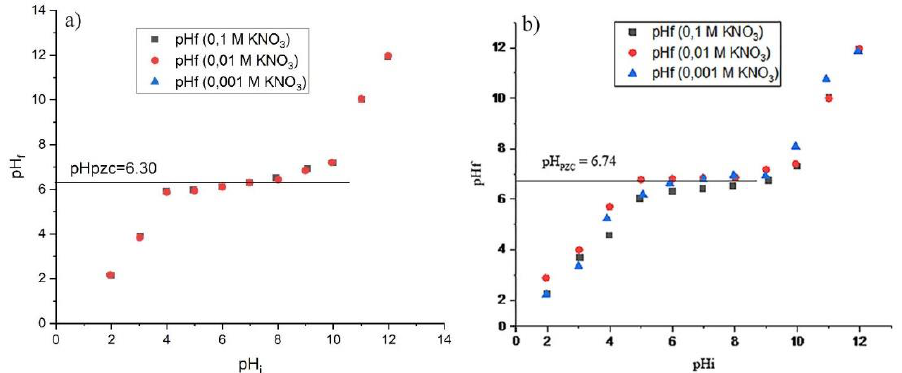
Fig. 3. The final pH(pH f ) versus initial pH(pH i ) change for: (a) DSNP, and (b)